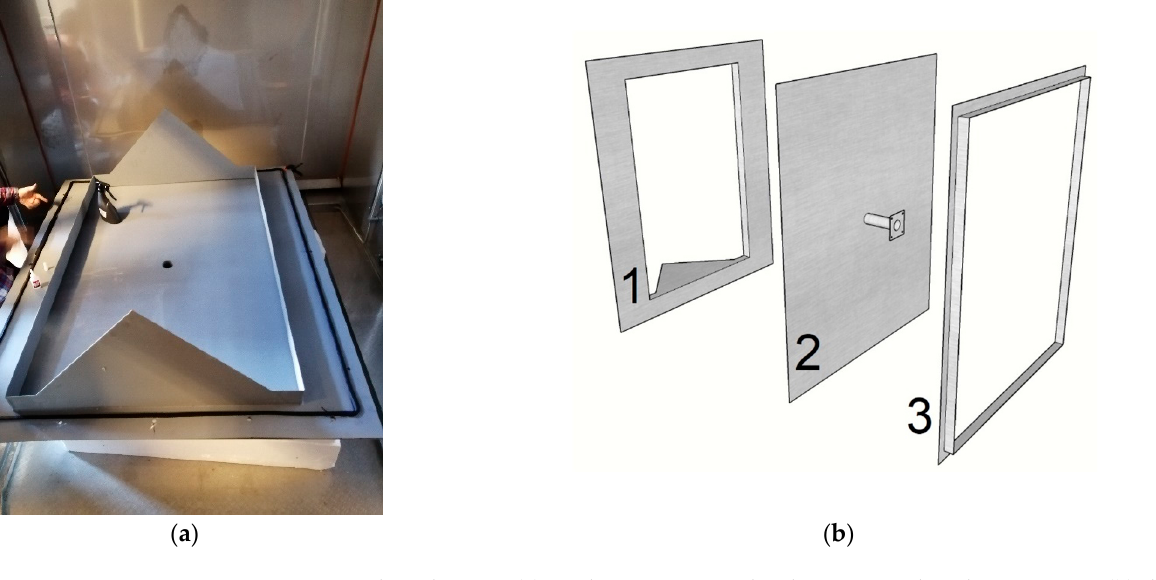
Figure 2. Special steel cover: ( a ) steel cover prepared to be connected to the specimen; ( b ) three individual parts of the steel cover.